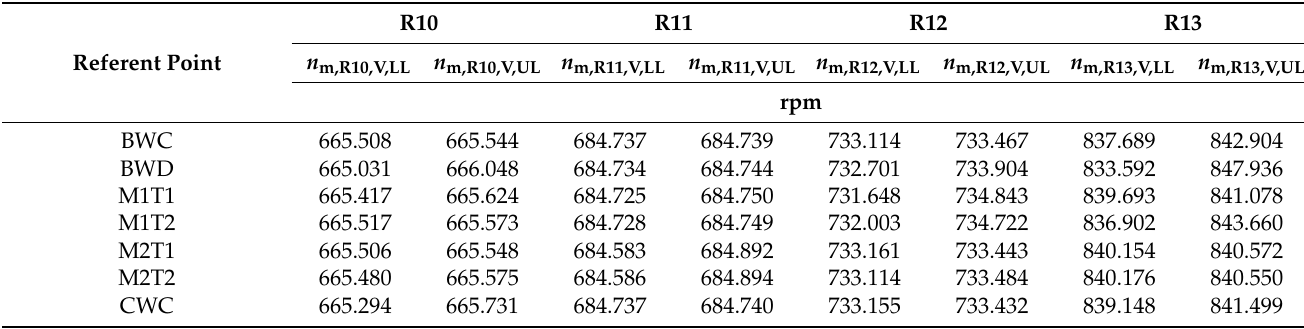
Table 11. Boundaries of the FREM resonant domains according to a V,per –EHO: 4.